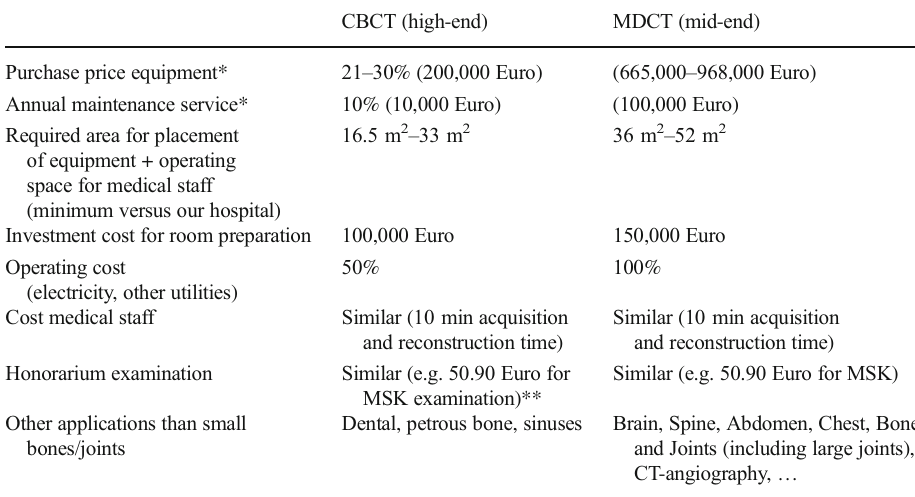
Table 1 Comparison of parameters influencing the economic rentabilty of CBCT versus MDCT